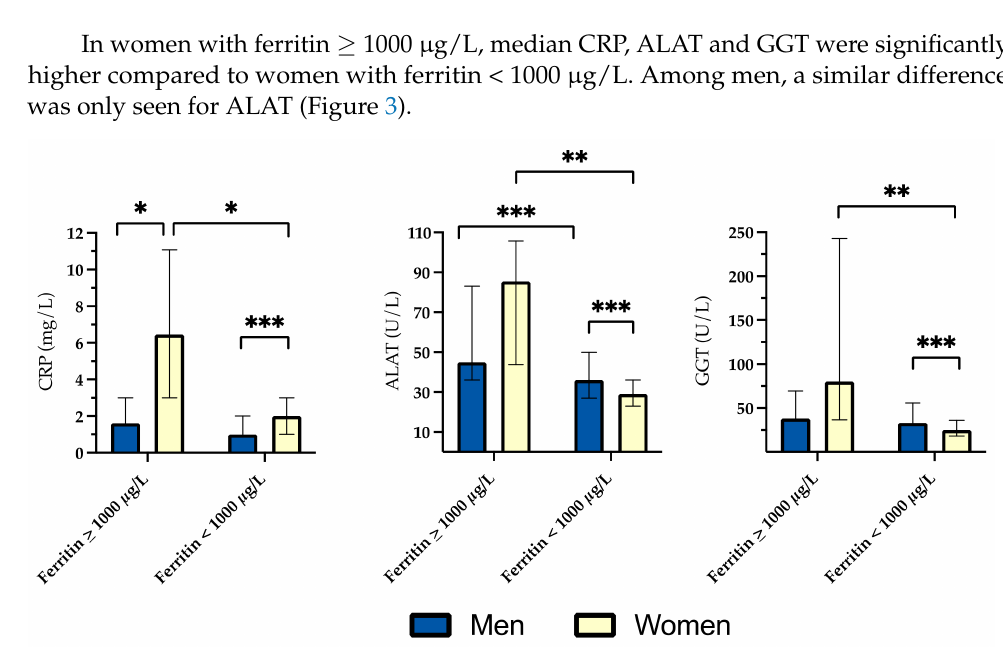
Figure 3. Median C-reactive protein (CRP), alanine aminotransferase (ALAT) and gamma-glutamyl transferase (GGT) in subjects with and without significantly elevated ferritin. Bars represent in- terquartile range. Significant p -values are indicated in figures with asterisks: * ≤ 0.05; ** ≤ 0.01; *** ≤